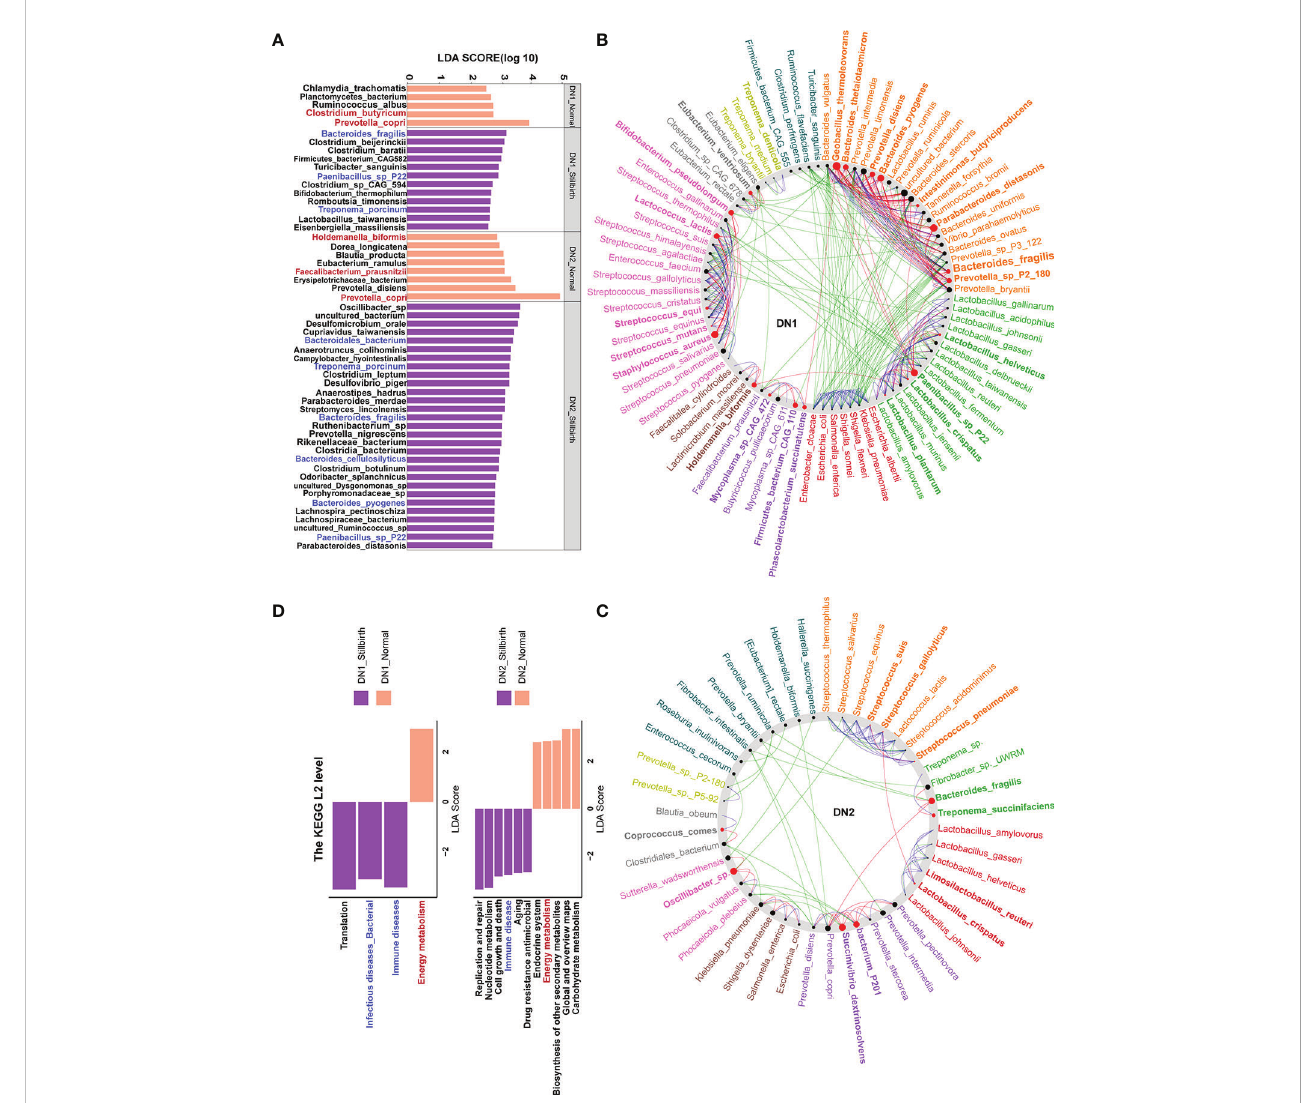
FIGURE 4 Bacterial species and functional capacities showing differential abundances between stillbirth and normal sow group in the DN1 and DN2 cohort based on metagenomic sequencing data. (A) Differential bacterial species between stillbirth and normal sows by LEfSe analysis (LDA score > 2.5 and P < 0.05). Blue taxa names represent the bacterial species or genus which were enriched in stillbirth sows from both DN1 and DN2 cohorts, and red taxa names indicate the species or SCFA-producing species which were enriched in normal sows from both DN1 and DN2 cohorts. (B, C) Co-occurrence networks of differential bacterial species in the DN1 (B) and DN2 (C) cohort using the NetShift tool. Nodes size showes the predicated “ driver ” scores, and red nodes indicate those species identi fi ed as important “ drivers ” . (D) Differential KEGG pathways between stillbirth and normal sow group by LEfSe analysis. Blue pathway names represent the diseases-associated pathways which were enriched in stillbirth sows from both DN1 and DN2 cohorts, and the red pathway name represents the pathway enriched in normal sows from both DN1 and DN2